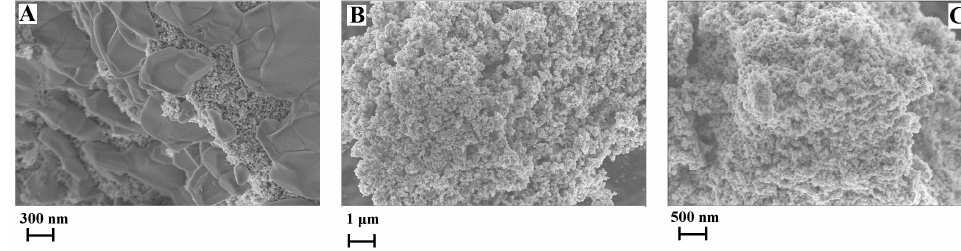
Figure 3. Transmission electron microscopic (TEM) images of the CuS prepared in different systems. Figure 4. Field-emission scanning electron microscopic (FE-SEM) images of the CuS prepared in different systems. ( A ) [C 4 C 2 OOHim]NTf 2 /Na 2 S, ( B ) [C 4 C 2 OOHim]NTf 2 /TAA (80 °C, 4 h) and ( C )